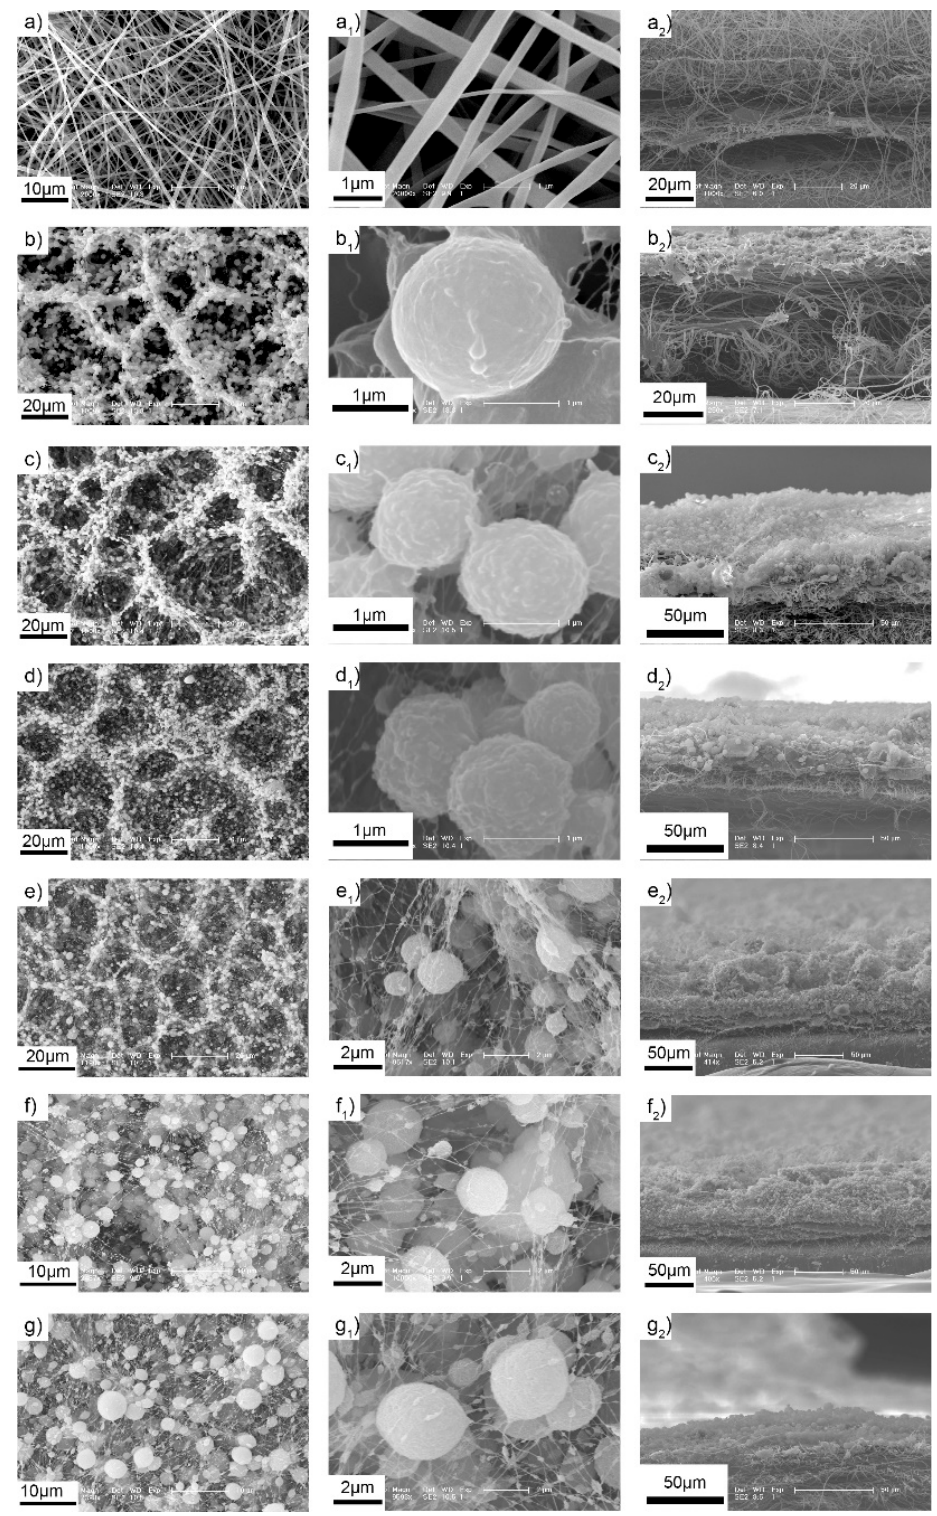
Figure 10. SEM of pure PVDF nanofiber membrane DP8 composite membrane and electrosprayed DP8–X with different SiO 2 content. ( a – a 2 ) PVDF, ( b – b 2 ) DP8, ( c – c 2 ) DP8–0.5, ( d – d 2 ) DP8–1.0, ( e – e 2 ) DP8–1.5, ( f – f 2 ) DP8–2.5, ( g – g 2 ) DP8–4.0.